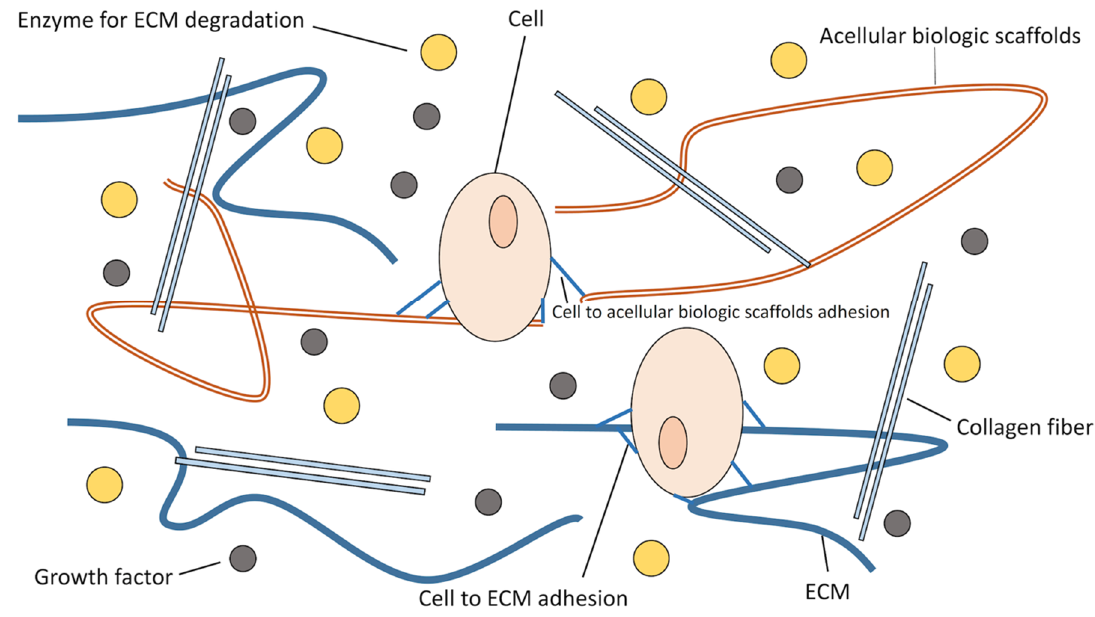
Figure 5. Natural environment of the ECM. The ECM provides nutriment to cells, signaling proteins responsible for intercellular communication, and mechanical support. ECM: extracellular matrix.